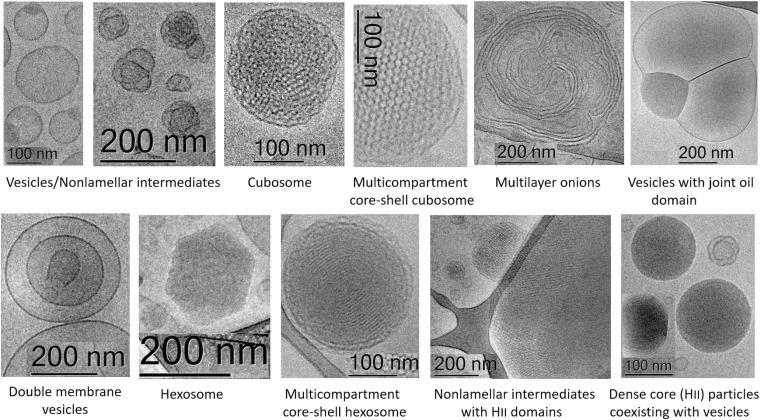
Summary of the different nanoscale topology types of docosapentaenoyl (DPA) plasmalogen- and ester-based liquid crystalline multiphase structures generated by spontaneous assembly in excess aqueous medium. Examples of individual cubosome and hexosome particles are given together with multiphase nanoparticles and intermediate structures formed as a result of inhomogeneous curvature distribution in the studied polycomponent lipid mixtures.